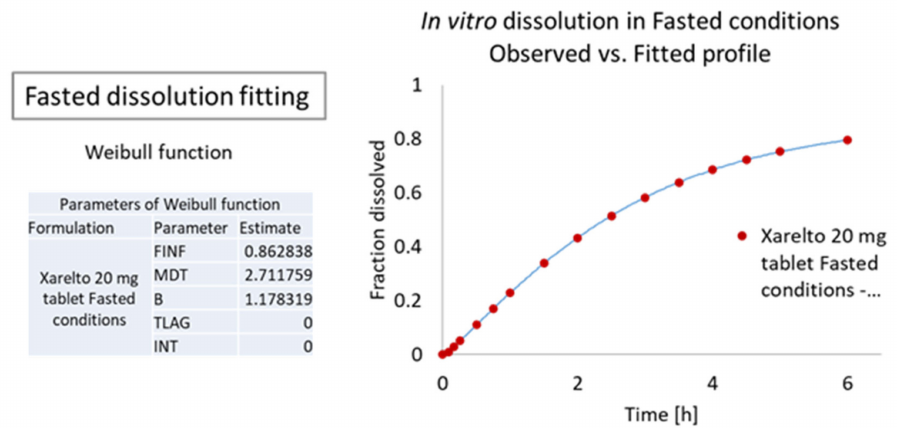
Figure 7. Observed in vitro profile vs. fitted curves of the Xarelto 20 mg tablet.